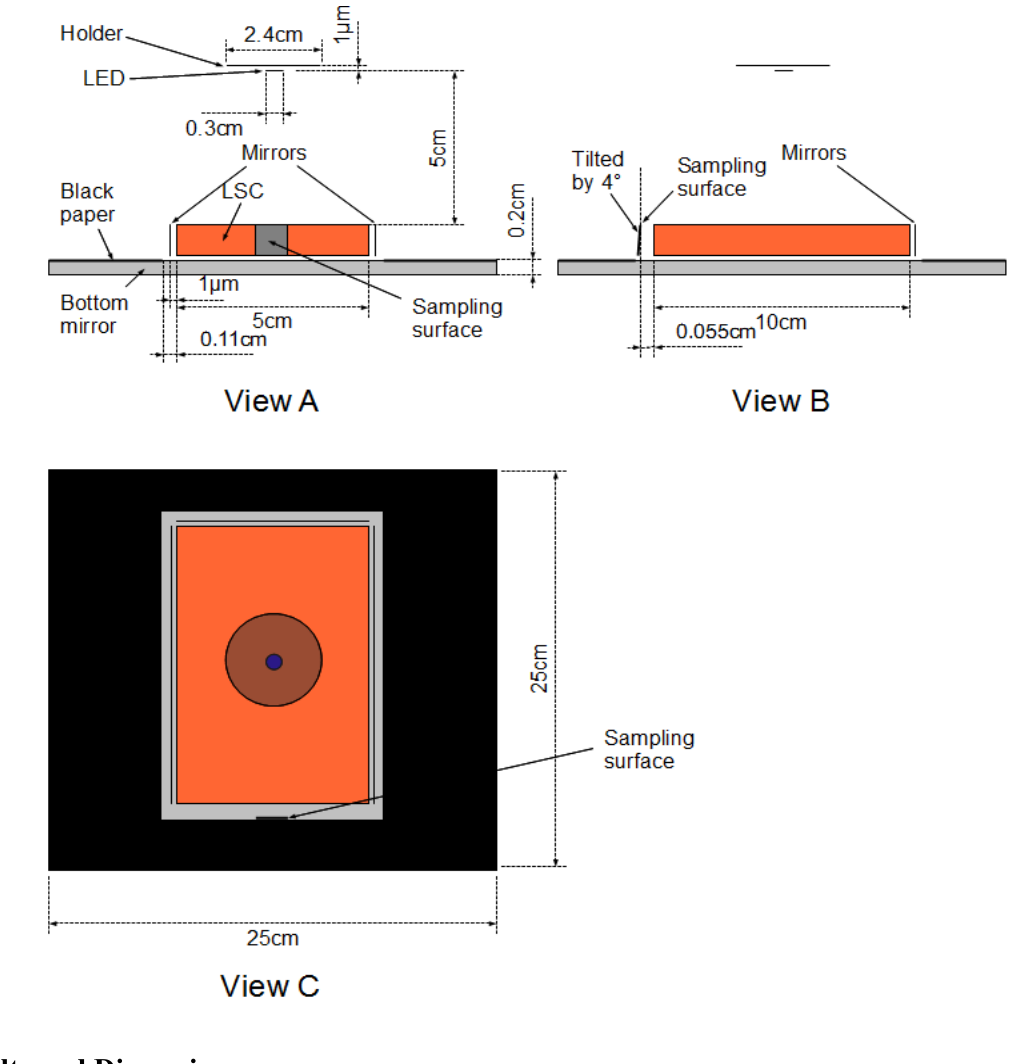
Figure 15. Two-dimensional view of the ray-tracing simulation